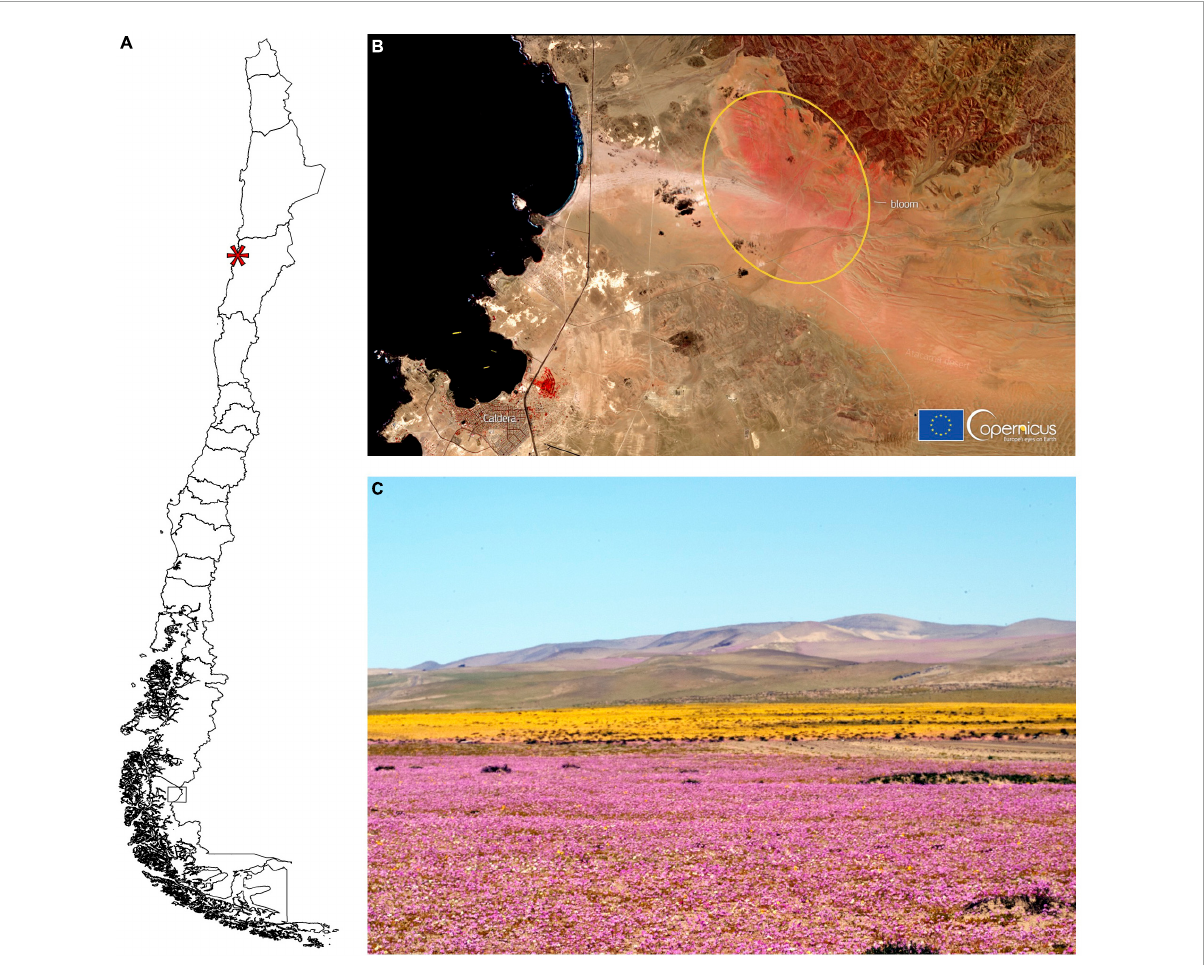
FIGURE1 Blooming in the Atacama Desert. (A) Map of Chile indicating with an asterisk the location of where the studied blooming event took place. (B) Copernicus satellite image from 13th October 2021 of the desert near the city Caldera (lower left) and the area with the abundant flower bloom (yellow ellipse) (Credit: European Union, Copernicus Sentinel-2 imagery). (C) Photograph of the area showing the dominant purple and yellow flower colors of Cistanthe longiscapa (photo by J.